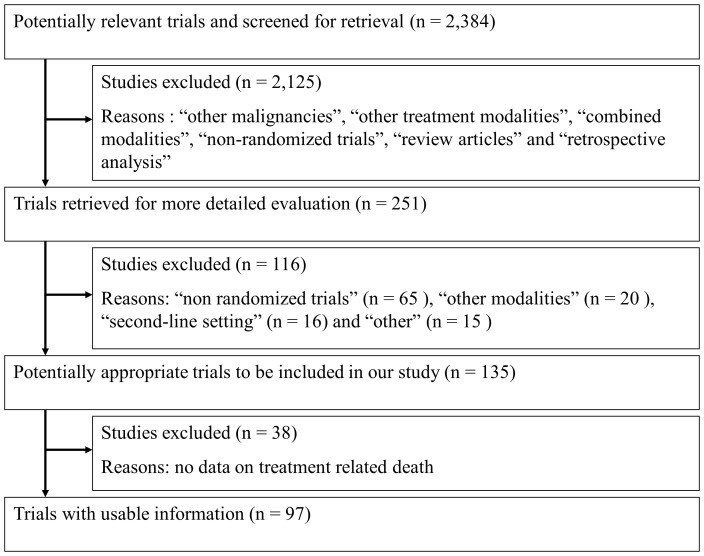
PRISMA flow diagram showing the progress of trials through the review.